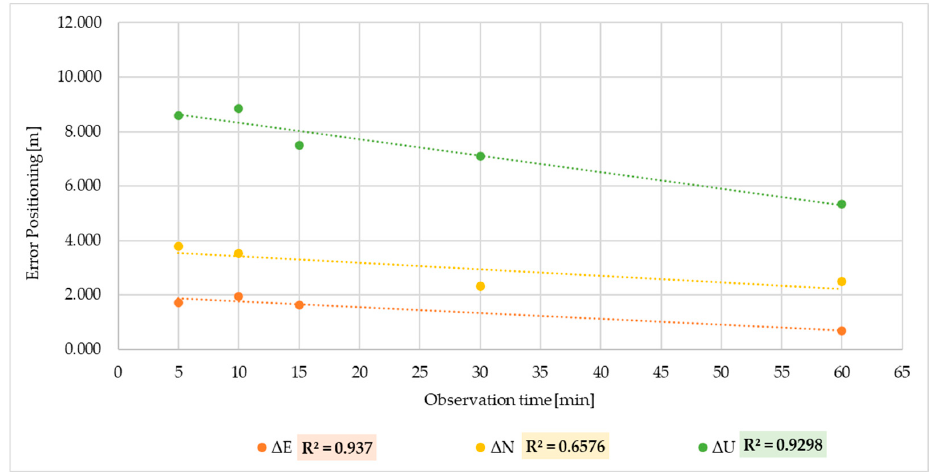
Figure 5. Linear regression between Δ E, Δ N and Δ U SPP error positioning and observation time.